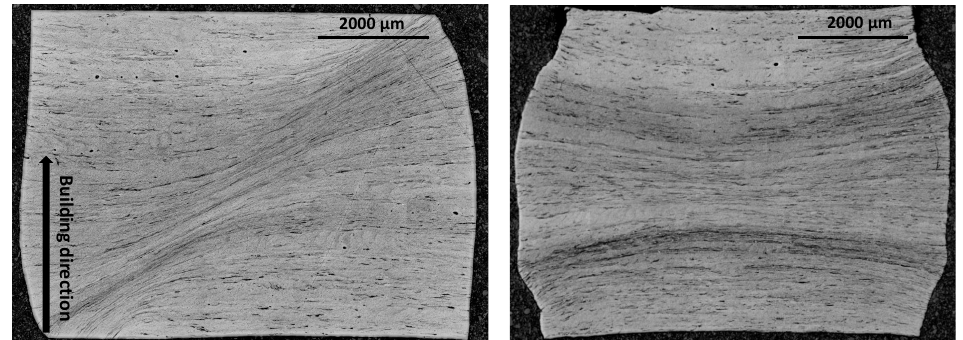
Figure 14. OM observations of Ti42Nb specimens manufactured with a building direction of 45 ◦ deformed at a strain rate of 10 s − 1 and two temperatures: ( left ) 298 K and ( right ) 1073